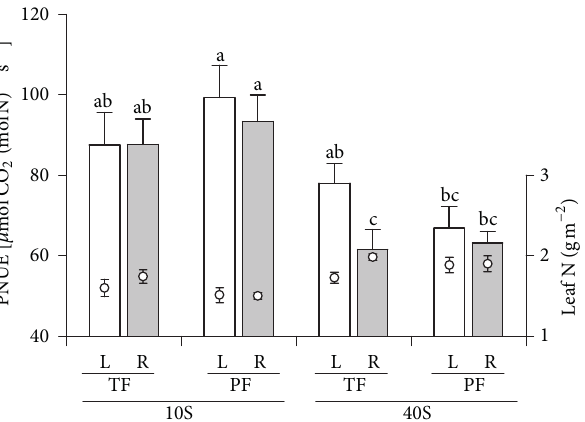
Figure 5: Stomatal conductance ( 𝑔 𝑤 ) as a function of the relative humidity within the sample cuvette of the Li-6400 for Laguncularia racemosa and Rhizophoramangle seedlingsduringtwotimeperiods. Data were pooled across